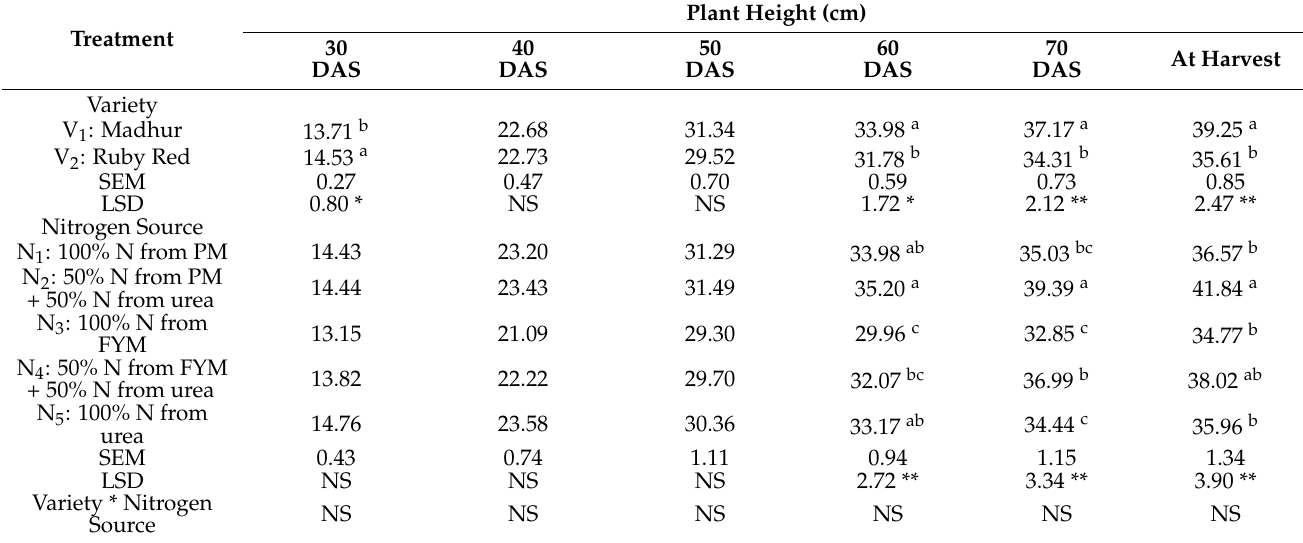
Table 1. Effect of variety and nitrogen source on plant height at different stages of beetroot at AFU, Rampur, Chitwan in 2018/19.